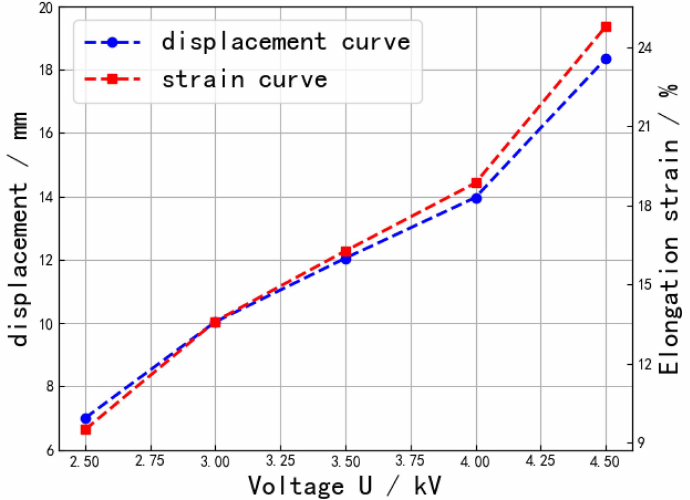
Figure 12. Single-degree-of-freedom simulation of the elongation displacement/strain–voltage curve of the drive